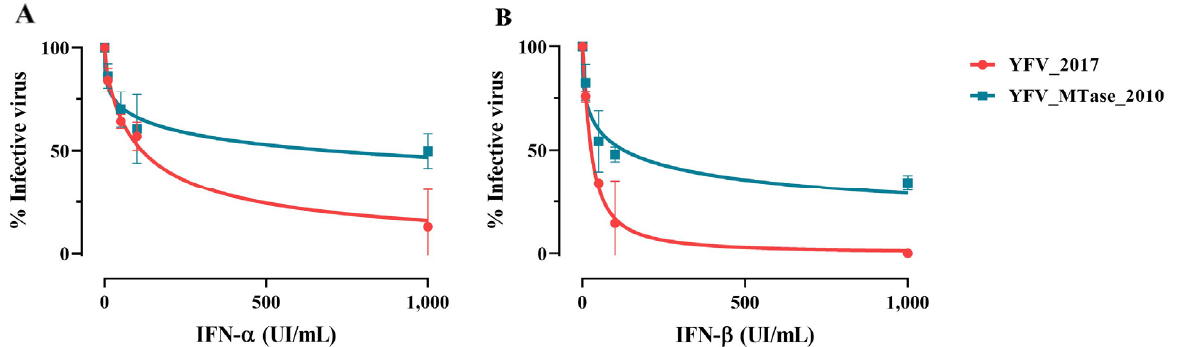
of YFV_2017 and YFV_MTase_2010. The asterisk in ( A ) represents the statistical significance with p